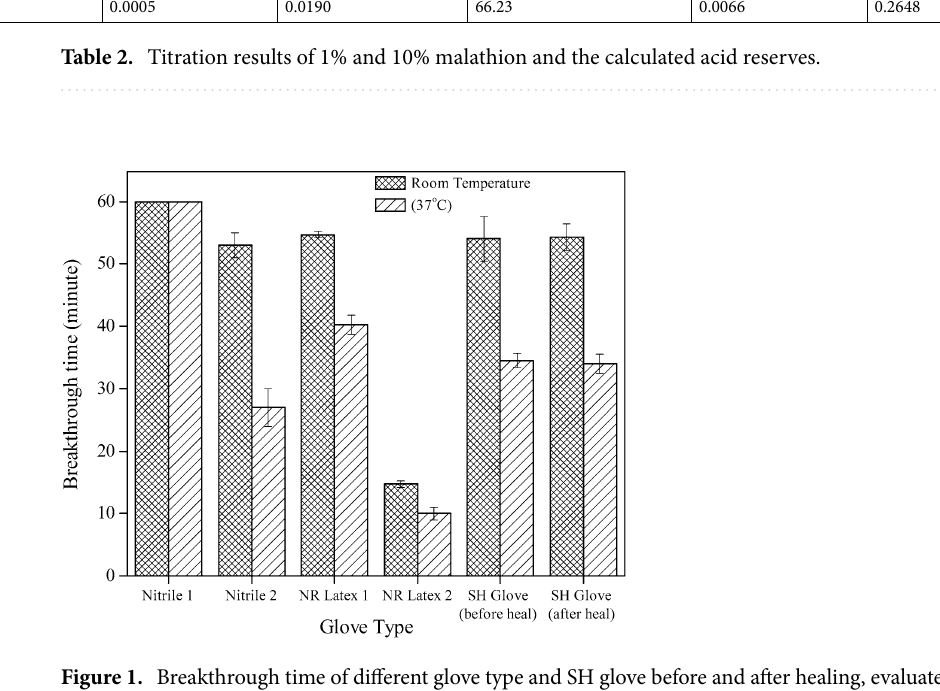
Figure 1. Breakthrough time of different glove type and SH glove before and after healing, evaluated at room temperature and 37 °C.